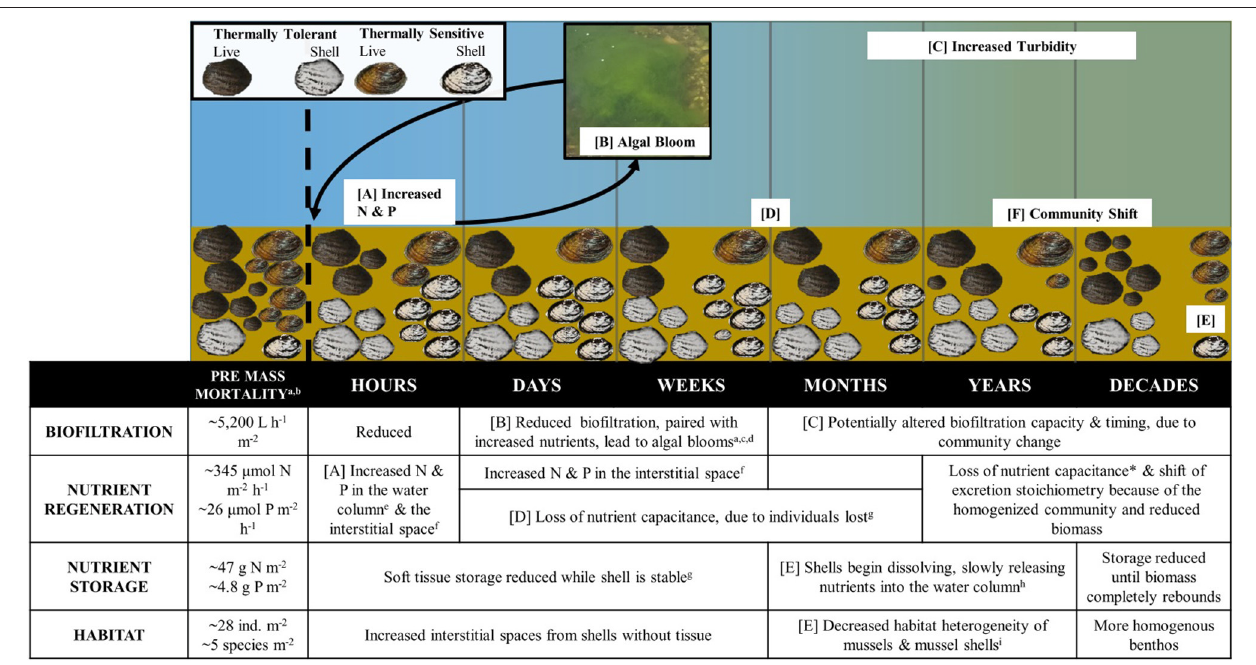
FIGURE 1 | Conceptual model depicting ecosystem function shift due to unionids at short and long time scales. Pre mass mortality information based on 25 ◦ C, downstream values for 1991 in Vaughn et al. (2015) for the biofiltration and community structure data and on Atkinson and Vaughn (2015) for downstream nutrient excretion and storage information. *Loss of nutrient capacitance dependent on mussel recruitment. Time increases to the left and the impact on mussels of four main ecosystem functions is described and depicted. Capital letters refer to distinct processes in the model, while lower case letters refer to sources: (a) Vaughn et al. (2015) , (b) Atkinson and Vaughn (2015), (c) McDowell et al. (2017), (d) Gagnon et al. (2004), (e) Cherry et al. (2005), (f) Cherry et al. (2005), (g) Atkinson et al. (2014), (h) Atkinson et al. (2018), (i) Ilarri et al.